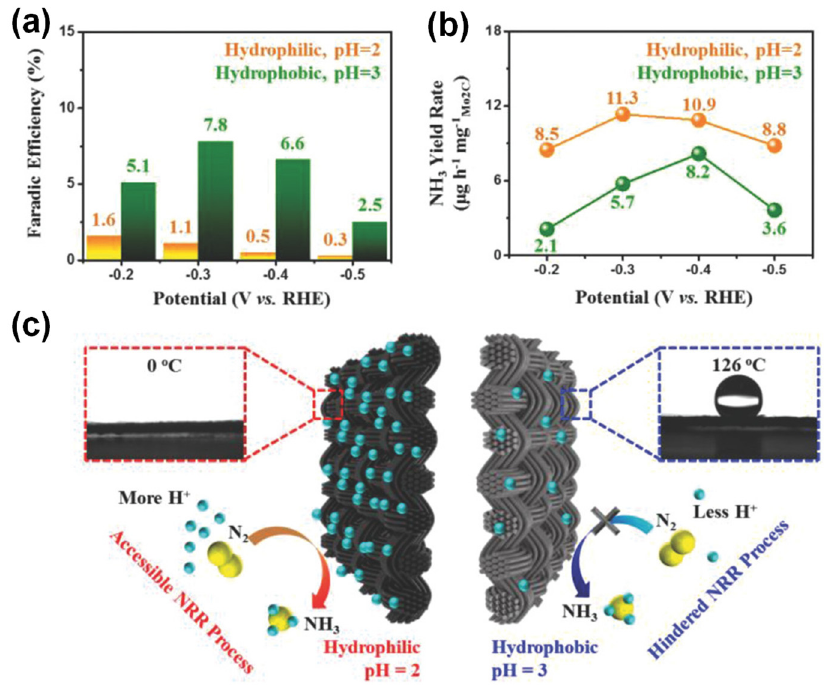
Figure 7. ( a ) Fes for ammonia and ( b ) corresponding yield rate over Mo 2 C/C catalyst. ( c ) Nitrogen reduction mechanism of the Mo 2 C/C under proton-suppressed and proton-enriched conditions, respectively [48]. Copyright 2018, Wiley-VCH.